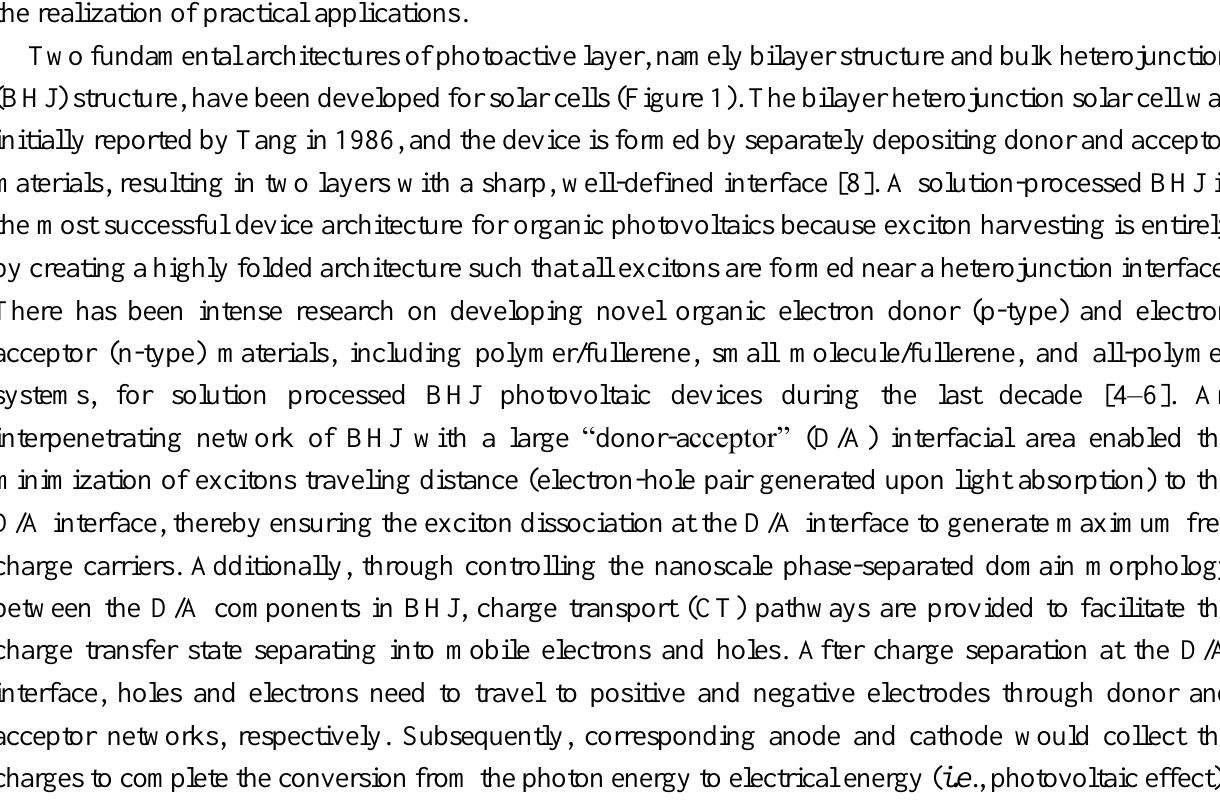
Figure 1. Fundamental architectures of photoactive layer: bilayer anf bulk